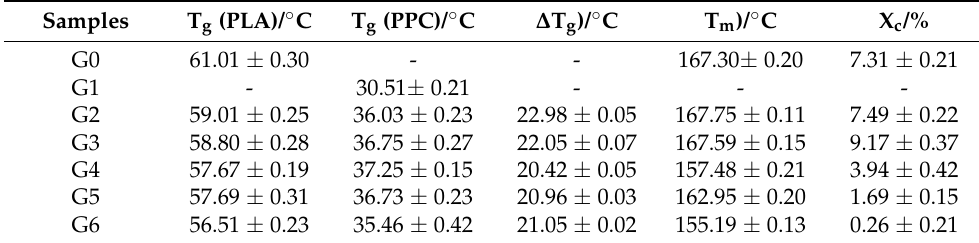
Table 6. Thermal properties of PLA, PPC, PLA/PPC and PLA/PPC/PLA-g-GMA